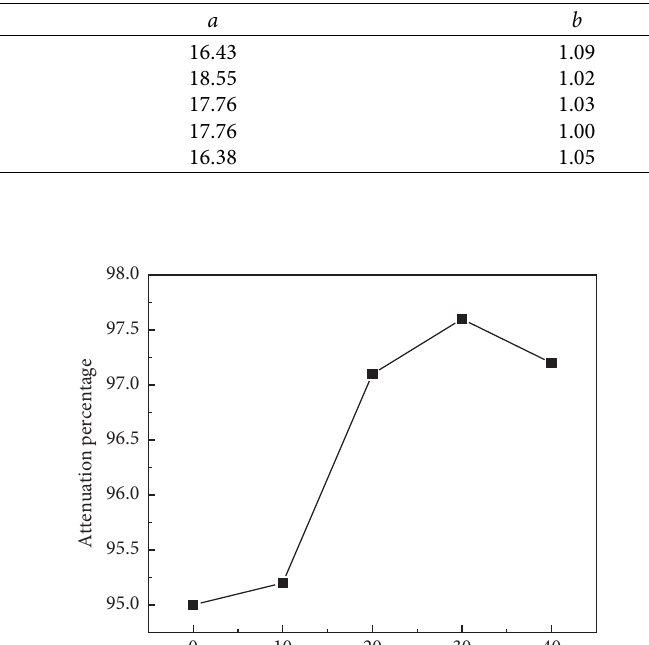
Table 6: Fitting parameters.